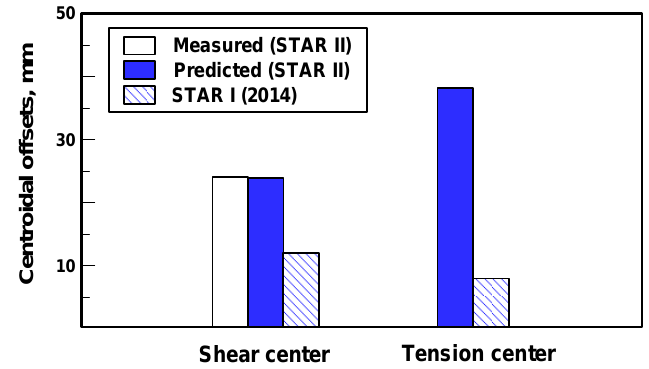
Figure 15. Comparison of centroidal offsets.